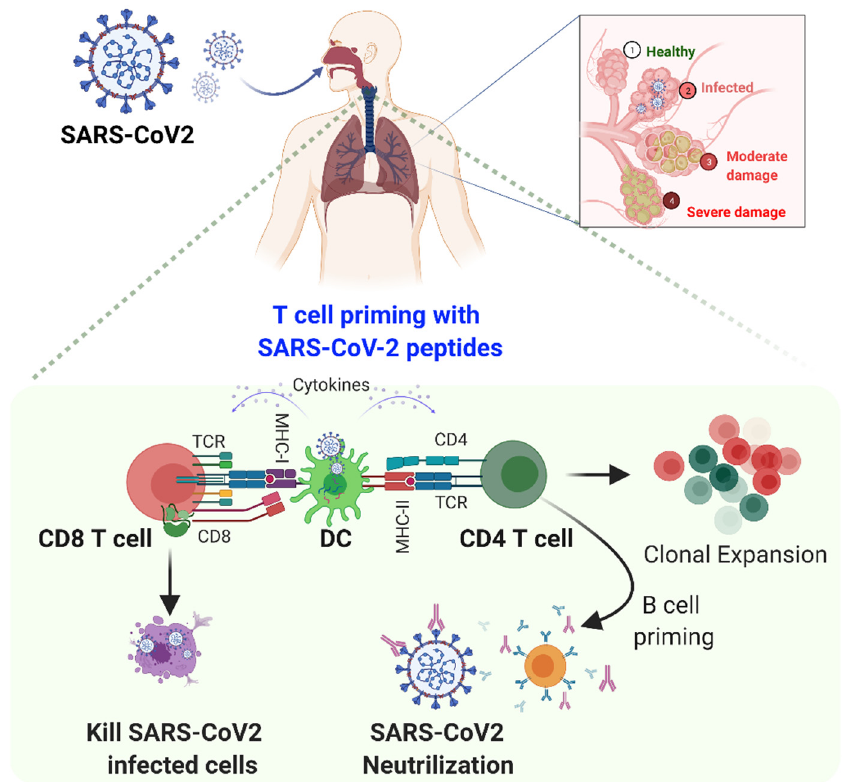
Figure 1. COVID-19 and host immune responses. Following inhalation of SARS-CoV2 into the respiratory tract, the virus traverses deep into the lower lung, where it infects a range of cells expressing its receptor ACE2, including alveolar airway epithelial cells, vascular endothelial cells, and alveolar macrophages. In the innate arm, immune cells primarily recognize the viral RNA by their receptors, such as Toll-like receptors (TLRs) that signal downstream to produce type-I/III interferons (IFNs) and pro-inflammatory mediators as the first line of defense. Furthermore, IFN triggers JAK/STAT signaling to activate interferon stimulating genes (ISGs) to fight SARS-CoV2. In the adaptive arm, the viral peptides are presented through major histocompatibility complex (MHC) class I proteins expressed by dendritic cells (DC) to CD8 T cells; these cells directly kill the virus-infected cells. Further, helper CD4+ T cells are activated through MHC-class II and differentiate B cells into plasma cells (antibody-producing cells) and memory cells. These SARS-CoV2 specific antibodies can neutralize the virus. Overall, both cells play an important role in eradicating SARS-CoV2 from the host.